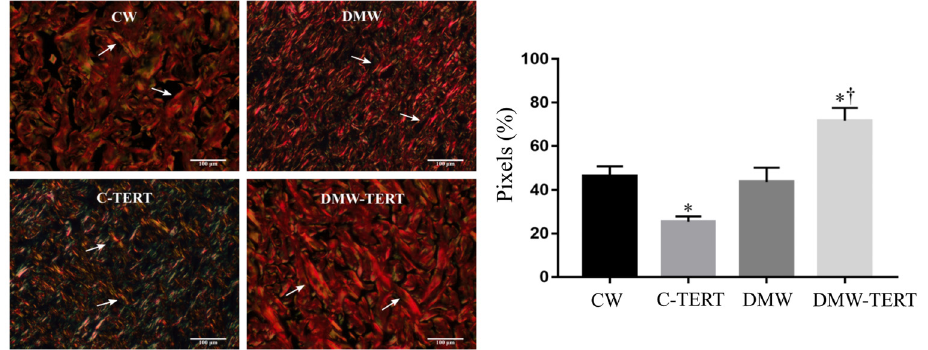
Figure 6. Quantitative birefringence analysis for the groups after treatment with human bone marrow mesenchymal cells immortalized by the expression of telomerase (hBMSC-TERT). White arrows indicate the birefringent fi bers. Data are reported as means ± SD. *P o 0.05 vs CW; w P o 0.05 vs DMW (ANOVA). Scale bar 100 m m. CW: control rats wounded; C-TERT: non-diabetic rats wounded and infused with hBMSC-TERT; DMW: diabetic rats wounded; DM-TERT: diabetic rats wounded and infused with hBMSC-TERT.